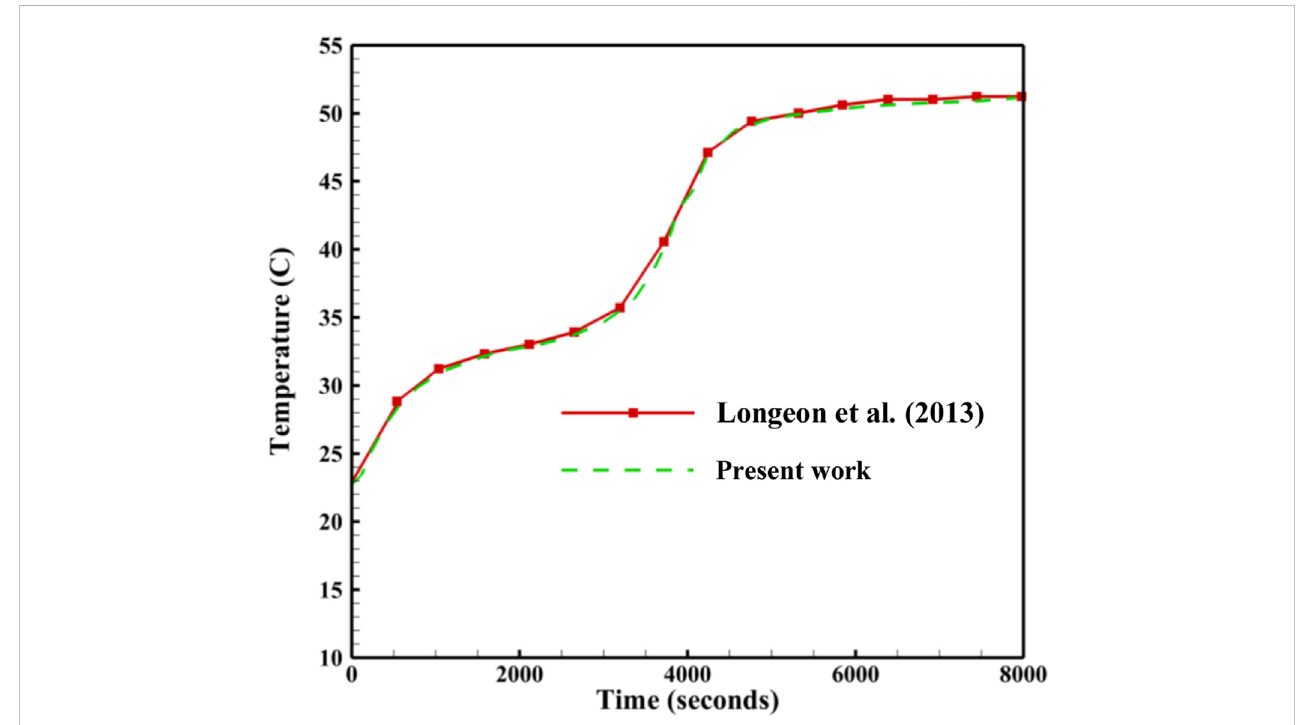
FIGURE 4 Assessment of the charging period acheived in the present study compared with the study of Longeon et al.